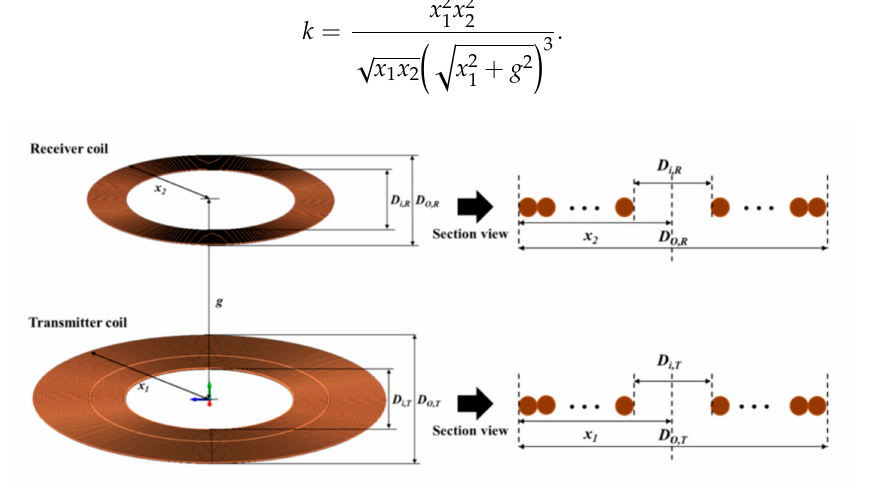
Figure 4. Geometries of the transmitter coil and receiver coil.